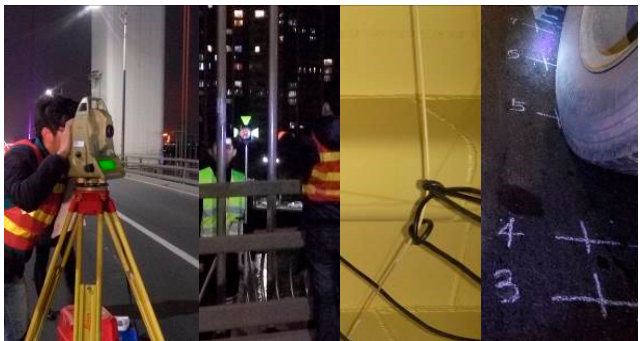
Figure 13. Methods to locate wheel loads.